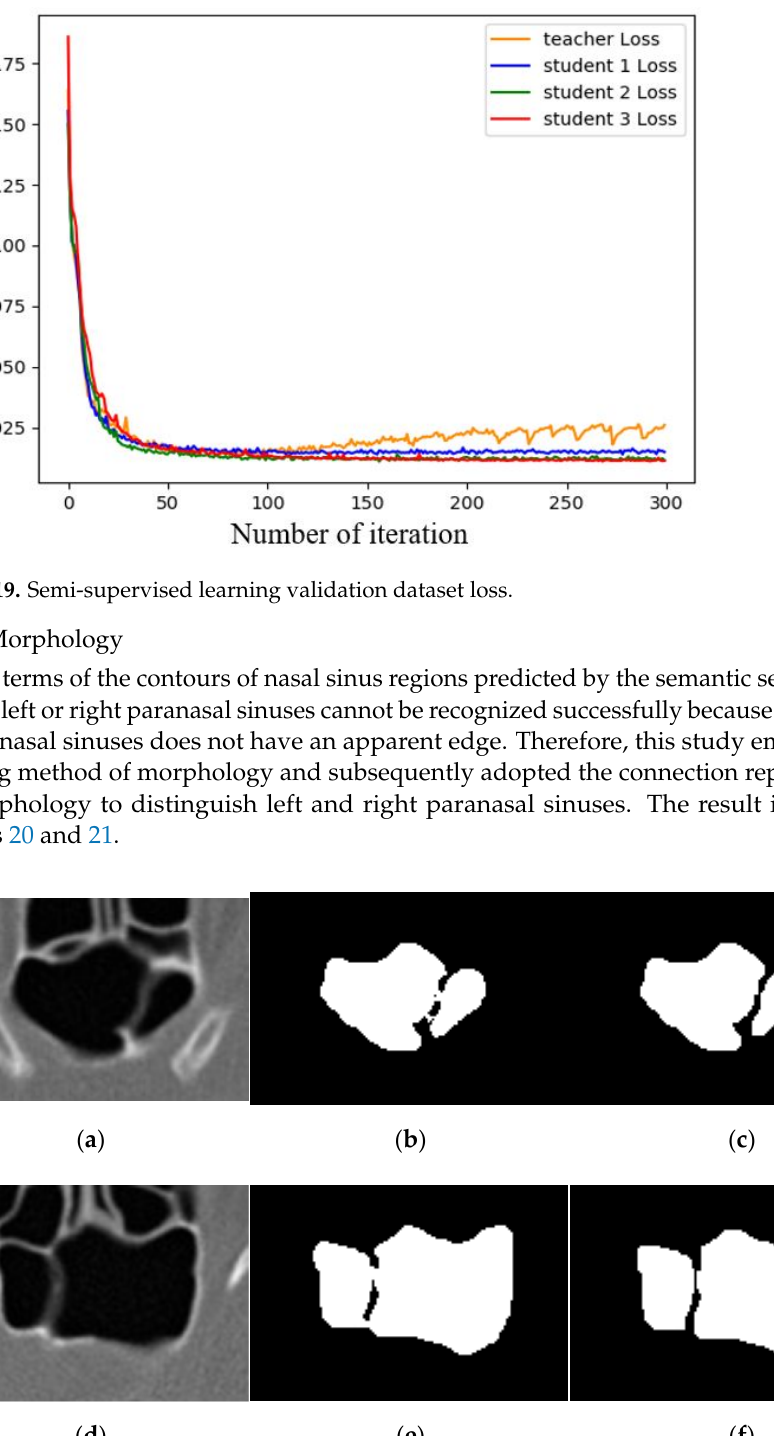
Figure 19. Semi-supervised learning validation dataset loss.